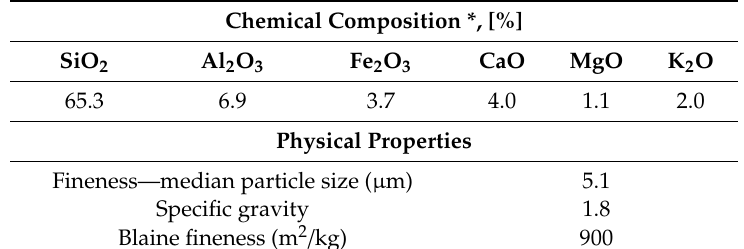
Table 6. Usual chemical and physical properties of sugarcane bagasse ash (SBA) [82].